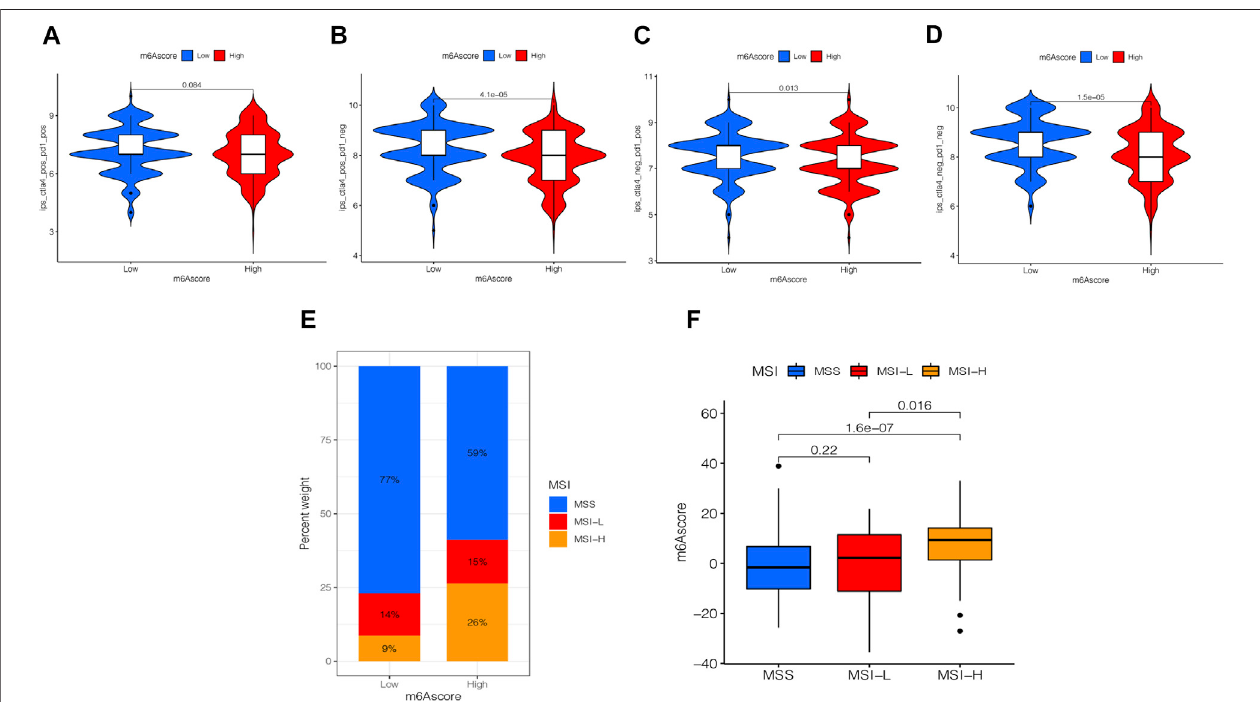
FIGURE 8 | Analysis of the m6A score in anti-PD-L1 and CTLA-4 immunotherapy. (A) Differential analysis for the low m6A score group and the high m6A score groupinimmunophenoscore(IPS)withCTLA4(+)/PD1(+)( p =0.084,Wilcoxontest). (B) Differentialanalysisforthelowm6Ascoregroupandthehighm6Ascoregroup inIPSwithCTLA4(+)/PD1 ( − )( p < 0.0001,Wilcoxontest). (C) Differentialanalysisforthelowm6Ascoregroup andthehighm6AscoregroupinIPSwithCTLA4( − )/PD1 (+) ( p = 0.013, Wilcoxon test). (D) Differential analysis for the low m6A score group and the high m6A score group in IPS with CTLA4 ( − )/PD1 ( − ) ( p < 0.0001, Wilcoxontest). (E) Theproportion ofthem6Ascoreingroups withhighor lowMSI andstablestatus. (F) Differencesinthe m6Ascoreamonghigh orlowMSIand stable status.ThedifferencesbetweenthethreegroupswerecomparedthroughtheKruskal-Wallistest.MSS,microsatellitestable;MSI-H,highmicrosatelliteinstability;MSI-L, low microsatellite